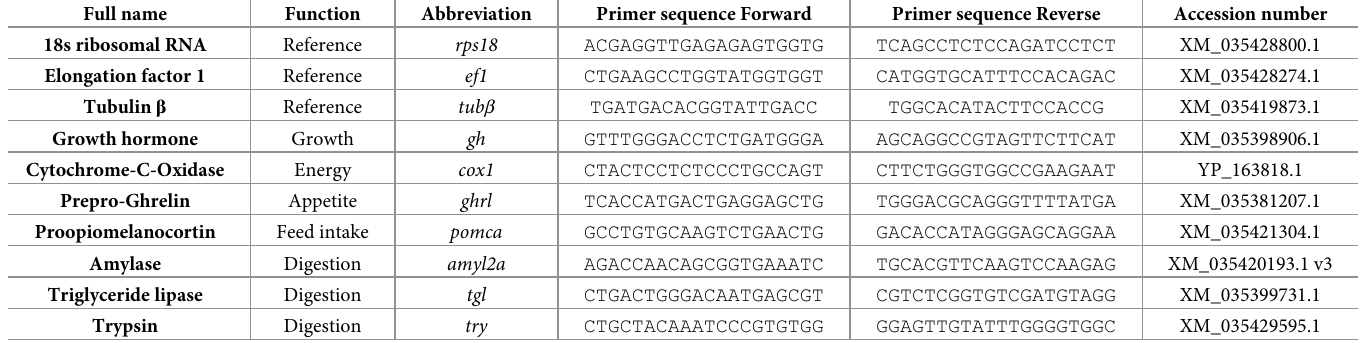
Table 3. Sequences of European eel, Anguilla anguilla primers used for amplification of genes by qRT-PCR. Primers were designed based on sequences available on Genbank